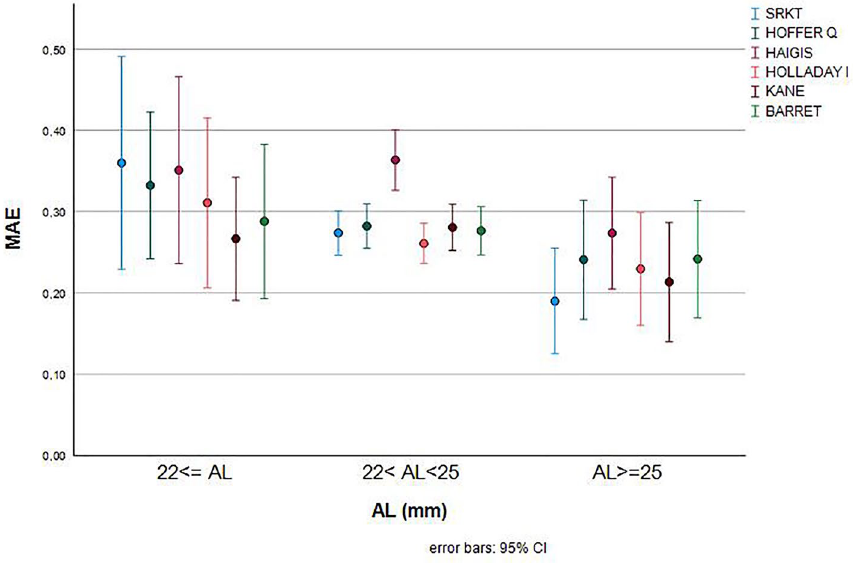
Figure 1. MAE according to AL and biometric